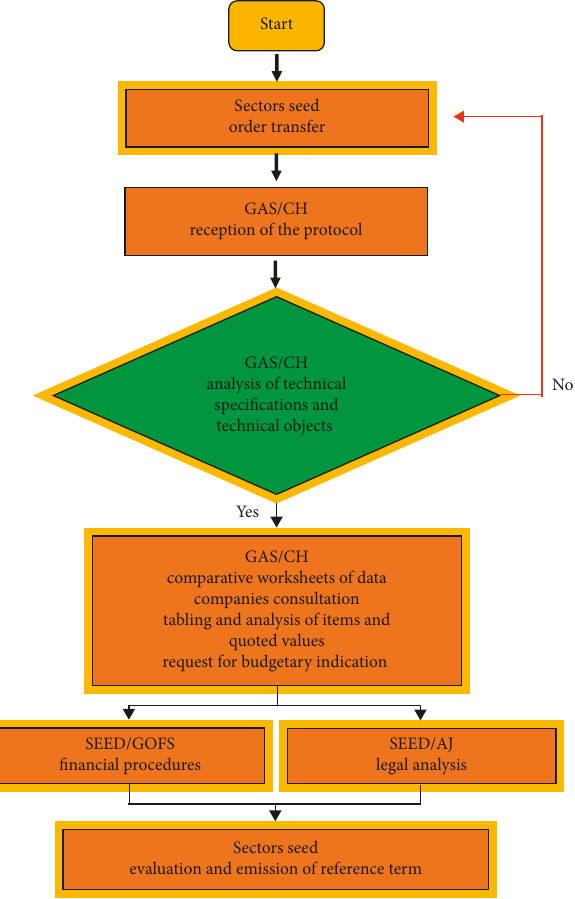
Figure 11: Flowchart drawing on case